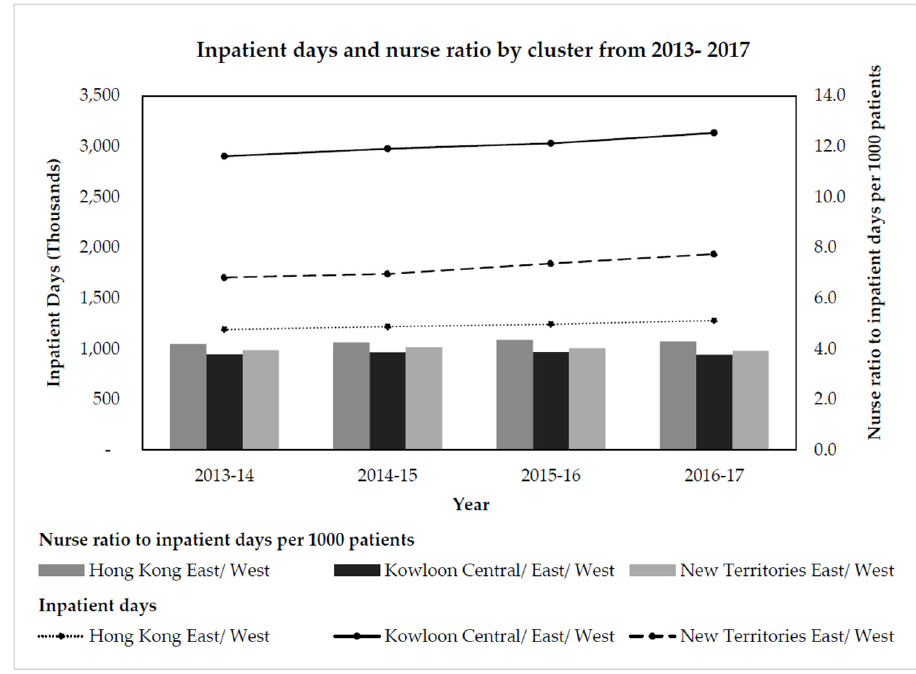
Figure 1 . Inpatient days and nurse ratio by cluster from